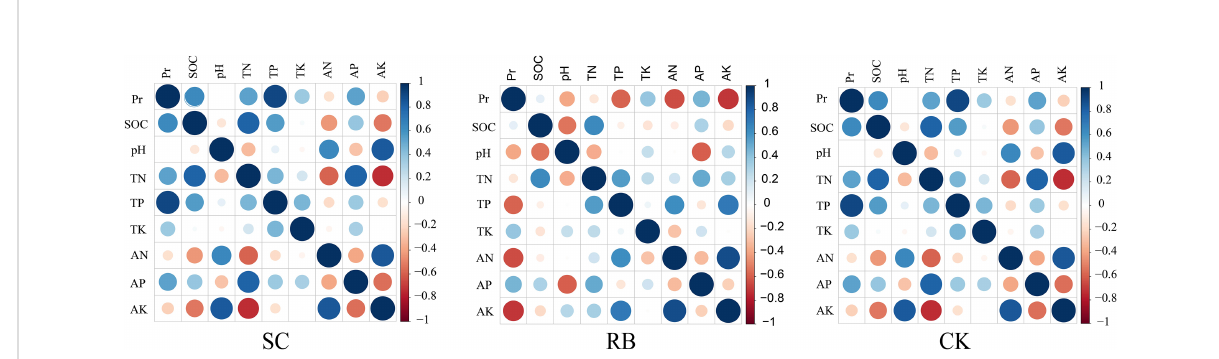
FIGURE 6 Correlation between productivity and soil nutrients in strip cut with 8m width (SC) and its reserved belts (RB), and the traditional management forest (CK). Pr is the bamboo